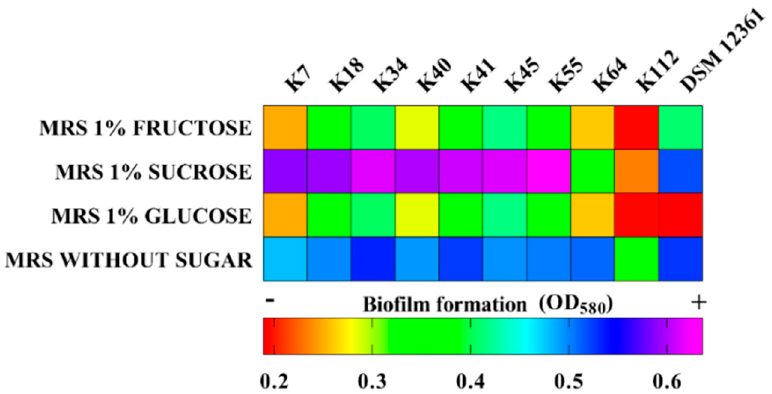
Figure 4. Biofilm formation in vitro of the L. kunkeei strains, expressed as Optical Density (OD) value at 580 nm.